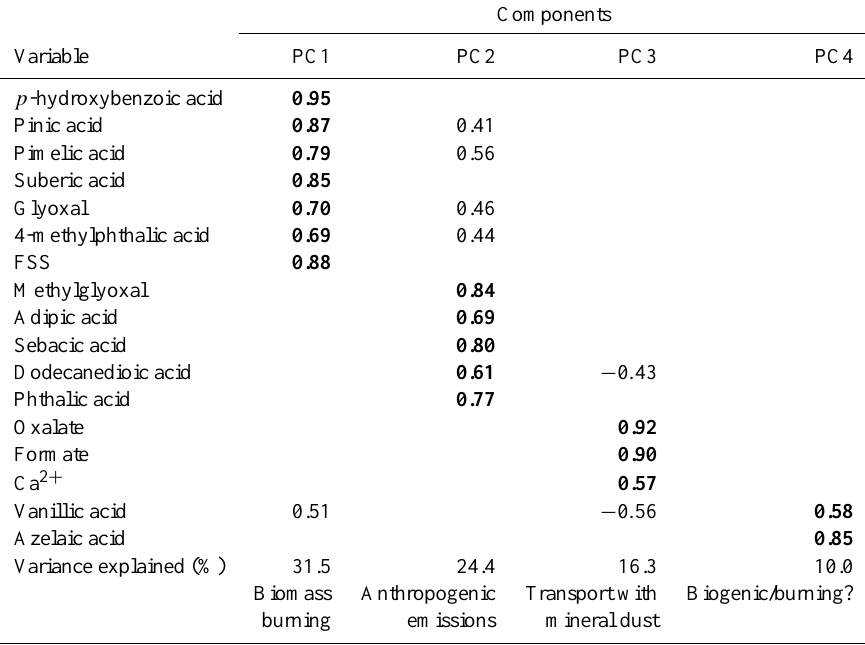
Table 3. Loadings of the PCA with Varimax rotation performed on the normalized 3-year means and the variance explained by each compo- nent for the time period 1942–1993. Factor loadings > | 0 . 4 | are shown. High loadings are indicated in bold.